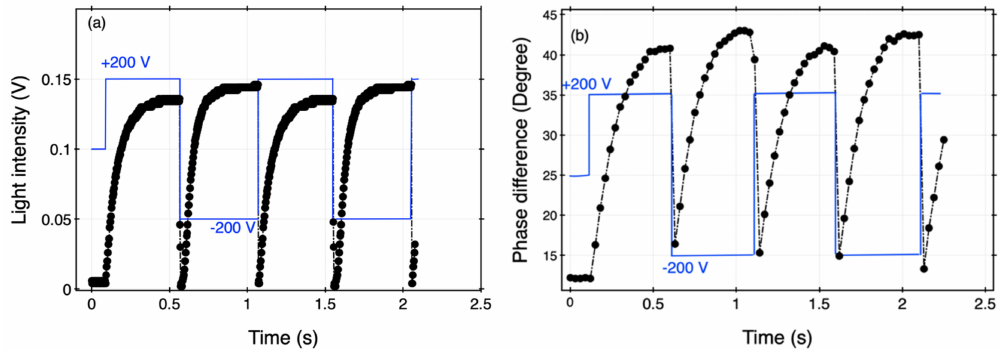
Figure 4. ( a ) Time evolution of the transmitting light intensity of the 10- µ m TFS-BPIII cell (also see the video taken from the microscope, Video S1). ( b ) Time evolution of the phase di ff erence which is recorded by the polarimeter when a 455-nm linear polarized light passes through the 10- µ m TFS-BPIII cell. The frequency of the applied field is 1